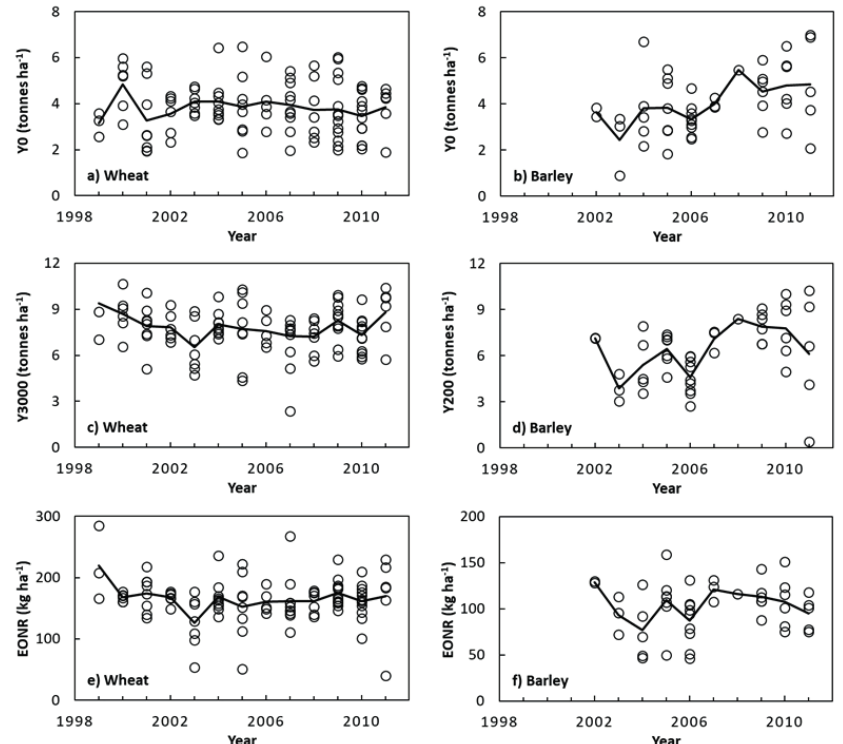
Fig. 1. Spatial and temporal variation in yield in (a-b) trial plots without fertilisation (Y0) and (c-d) trial plots receiving an N rate of 300 or 200 kg N ha -1 ). Plots (e-f) show the economic optimum nitrogen rate (EONR). Each circle represents one field trial and the solid lines represent the time series of yearly averages. Finding the best predictor(s)